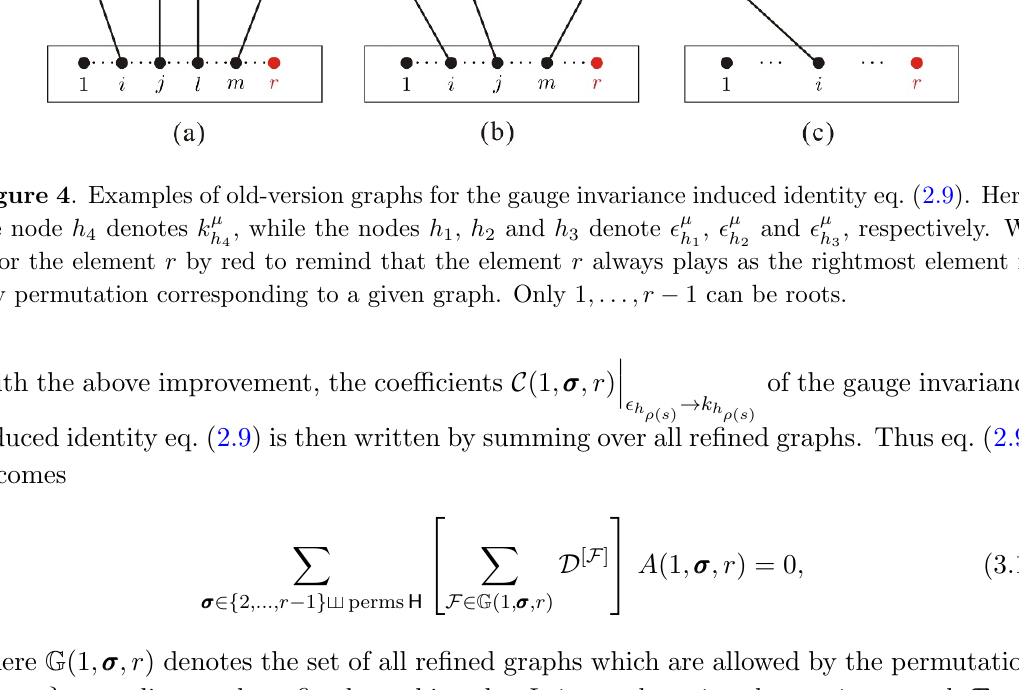
, (cid:15) (cid:22) and (cid:15) (cid:22) , respectively. We h 1 h 2 h 3